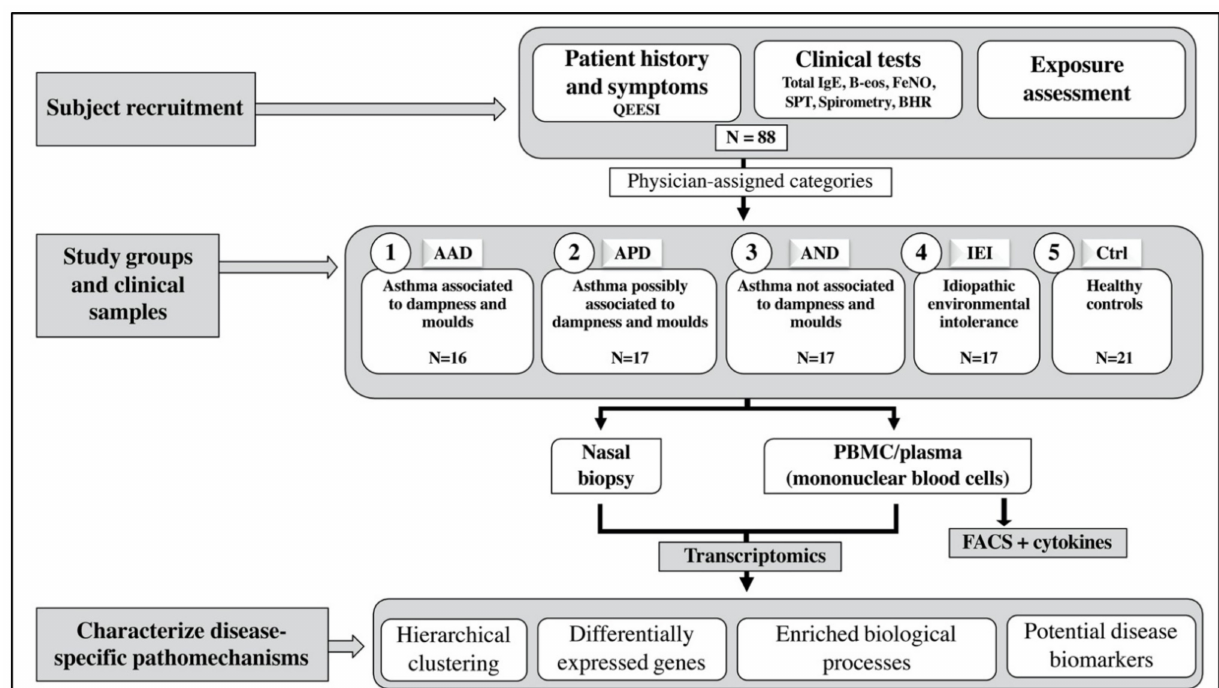
Figure 1. Flowchart outlining sample categorization and study workflow. Clinical tests included spirometry, assessment of non-specific bronchial hyperresponsiveness (BHR), fractional exhaled nitric oxide (FeNO), and blood eosinophil (B-eos) counts. Allergy to common environmental allergens was determined via skin prick testing (SPT). The Quick Environmental Exposure and Sensitivity Inventory questionnaire (QEESI) was used to assess idiopathic environmental intolerance. Nasal biopsies and peripheral blood mononuclear cell (PBMC) samples were obtained. Disease mechanisms were investigated with gene expression profiling, cytokine analysis (ELISA), and immune cell subtype profiling